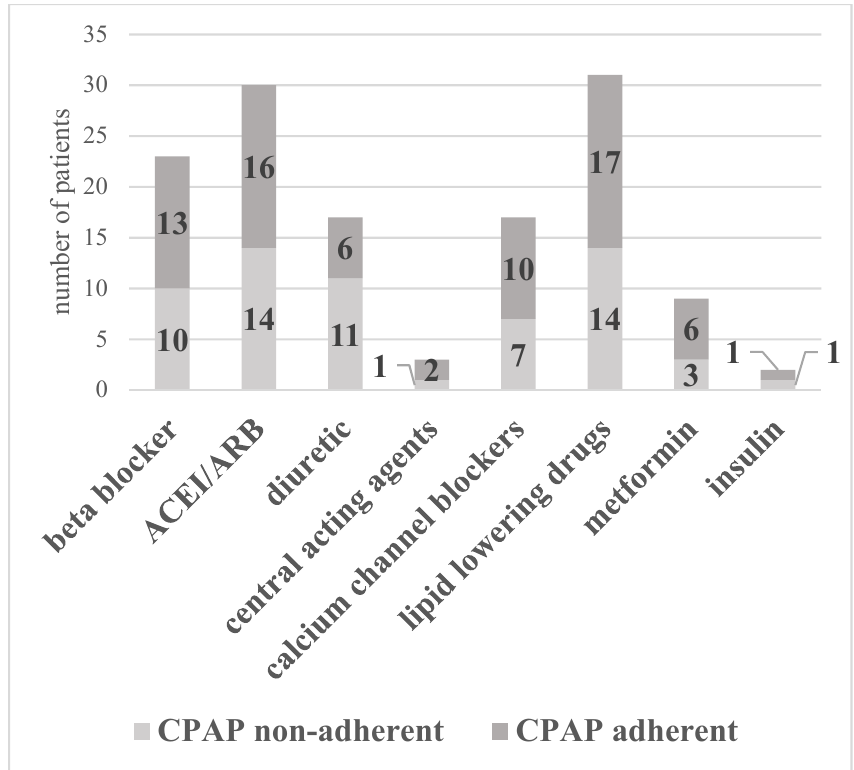
Figure 2. The use of anti-hypertensive, anti-diabetic, and lipid-lowering medications in the two sub- groups, CPAP non-adherent and CPAP adherent. ACEI: angiotensin-converting enzyme inhibitors; ARB: angiotensin receptor blockers; CPAP: continuous positive airway pressure.